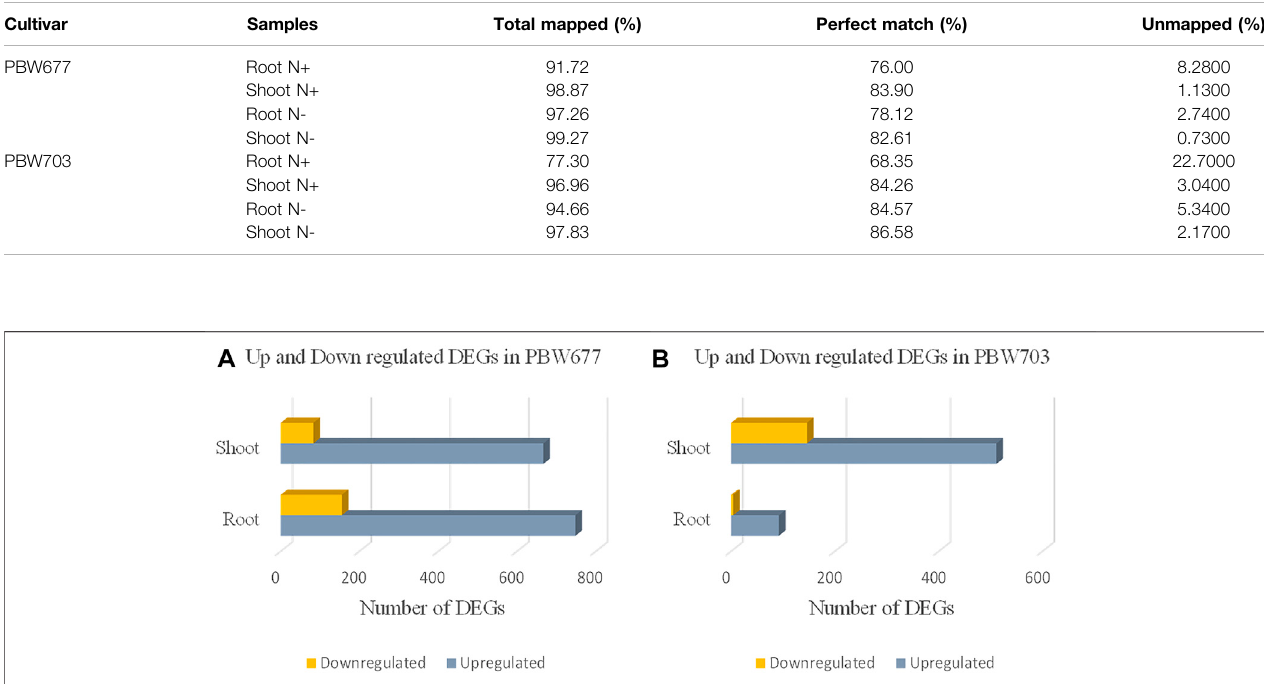
Frontiers in Genetics |